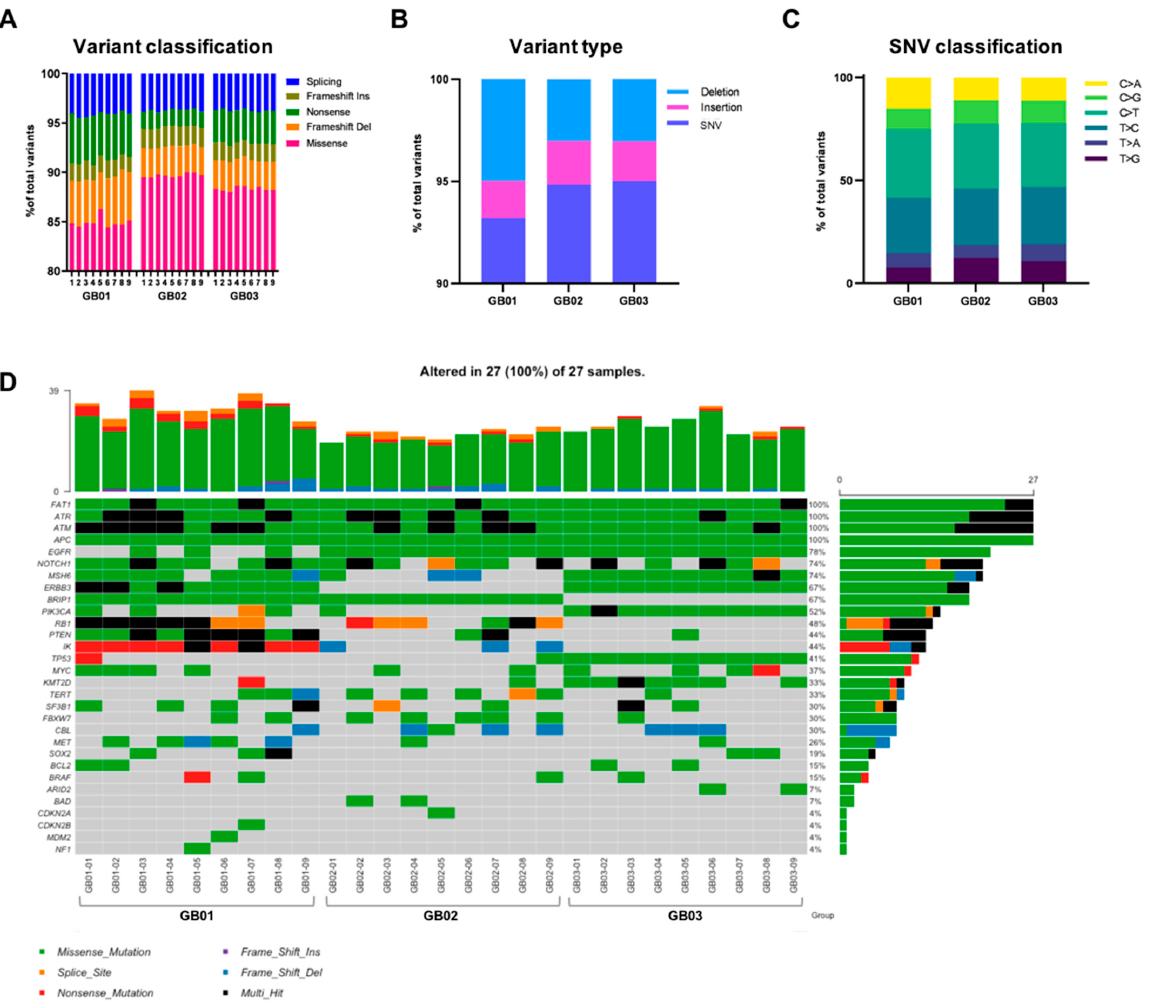
Figure 3. Mutation spectrum in GB. ( A ) Percentage of variant classification, plotted as a percentage of the total number of variants detected. ( B ) Percentage of mutation type, plotted as a percentage of the total number of variants detected. ( C ) Percentage of single-nucleotide variant (SNV) classification, plotted as a percentage of the total number of SNVs detected. ( D ) Oncoplot of the distribution of mutations found in our samples in the most frequently mutated genes in GB. Each column represents one sample (9 regions per tumor) and each row a different gene. Colored squares show mutated genes, while empty (gray) squares show no mutated genes. The different types of mutations are colored according to the type of variant: orange, splice site mutation; blue, frameshift deletion; green, missense mutation; red, nonsense mutation; and black, multi-hit mutation. Genes annotated as “multi-hit” have more than one type of mutation in the same region. The bar graph on the right shows the total number and percentage of mutated regions for each gene, out of the total 27 regions, colored according to mutation type. The upper graph shows the total number and type (different color) of mutations for each tumor region. 3.4. Somatic Mutations Somatic mutations were called using Mutect2 [19]. We started by focusing on the genes known to be altered in GB IDH1-WT, referring to two databases: my cancer ge- nome–MCG, mycancergenome.org and American Brain Tumor Association (ABTA), abta.org. We found 30 mutated genes in the three GB samples from a total of 264 different variants. The oncoplot in Figure 3D represents each of the 30 genes: the type(s) of gene mutation present in each of the 27 intra-tumor regions (colored square, middle section of